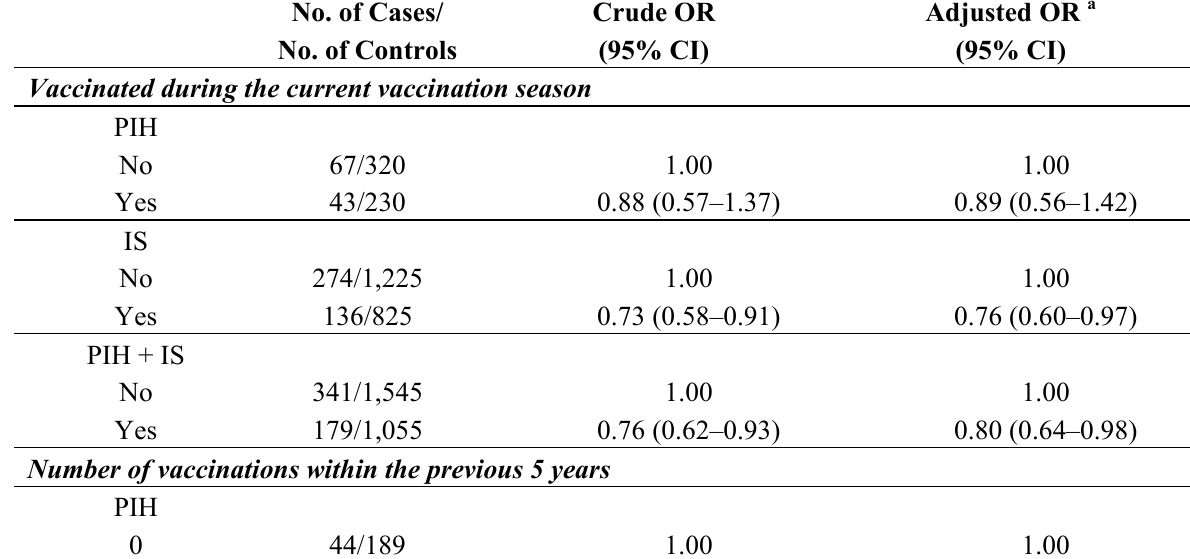
Table 2. Associations of influenza vaccination with the risk of stroke hospitalization in a population-based case-control study, 2006–2009,